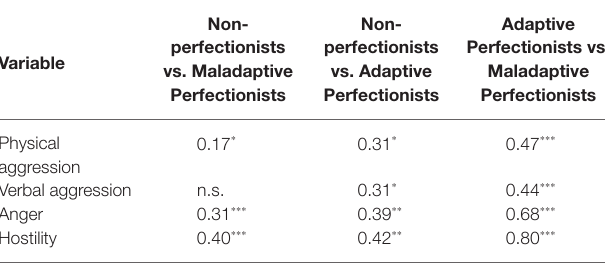
TABLE 4 | Cohen’s d indexes for post hoc contrast